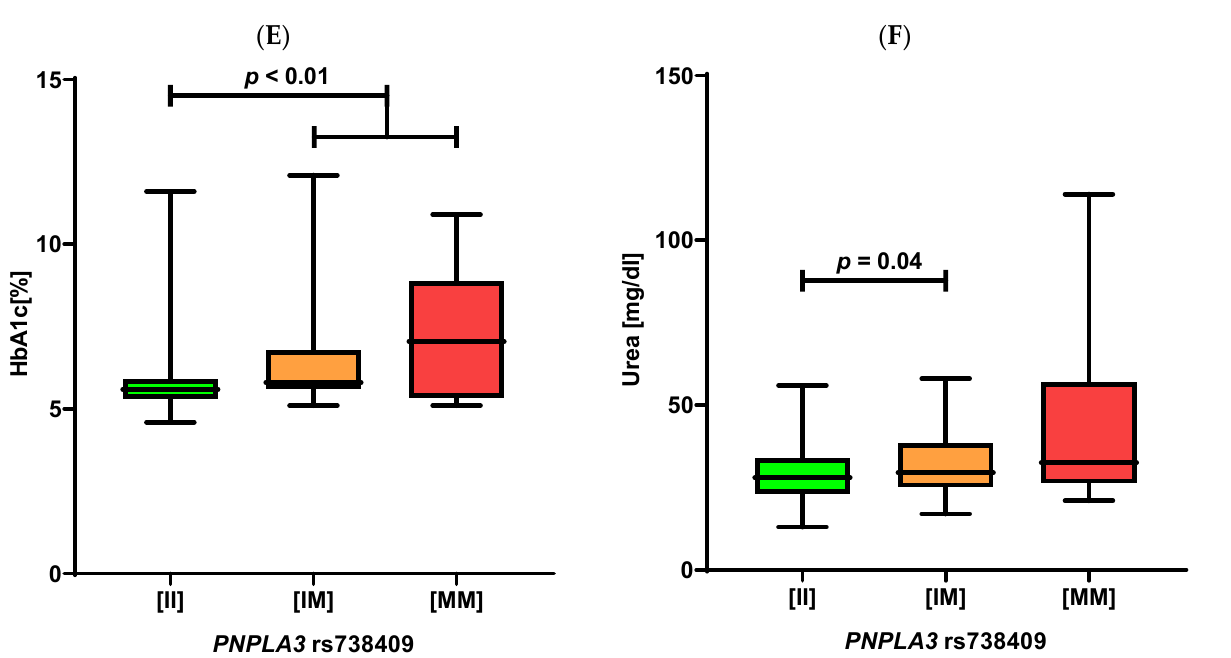
Figure 1. ( A ): Distribution of the MTARC1 minor allele in relation to liver fibrosis at liver biopsy in individuals undergoing bariatric surgery. F0 n = 31, F1a–b n = 29, F1c n = 14, F2 n = 7. ( B , C ): Association between the HSD17B13 polymorphism and serum ALT ( B ) and AST activities ( C ). Genotype frequencies: [TT] n = 102, [TTA] n = 51, [TATA] n = 12. ( D – F ): Association between the PNPLA3 variant and glucose ( D ), HbA1c ( E ), and urea ( F ) levels. Genotype frequencies: [II] n = 117, [IM] n = 42, [MM] n = 6.